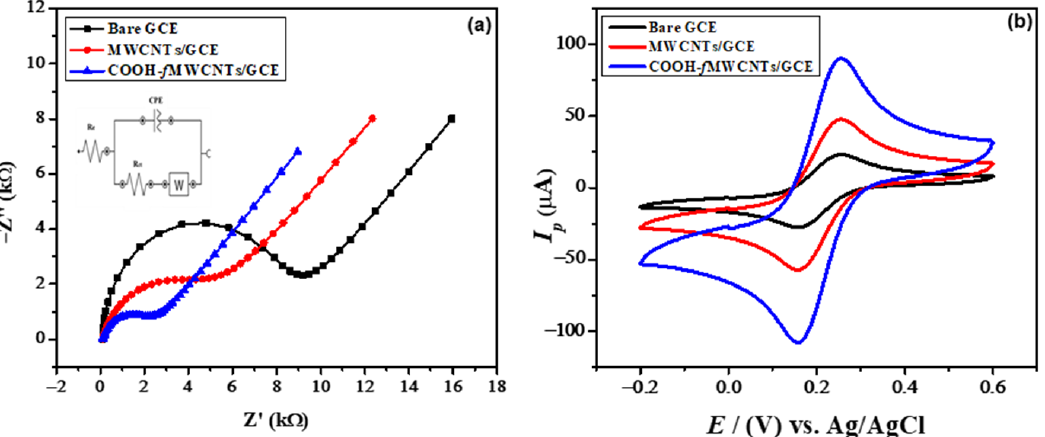
Figure 1. ( a ) Nyquist plots using data obtained at bare and modified GCE in a solution of 5 mM K 3 [Fe(CN) 6 ] as a redox probe and 0.1 M KCl as a supporting electrolyte. ( b ) Cyclic voltammograms at the bare and modified GCE in 5 mM K 3 [Fe(CN 6 )] as redox probe and 0.1 M KCl as supporting electrolyte at a scan rate of 100 mV s − 1